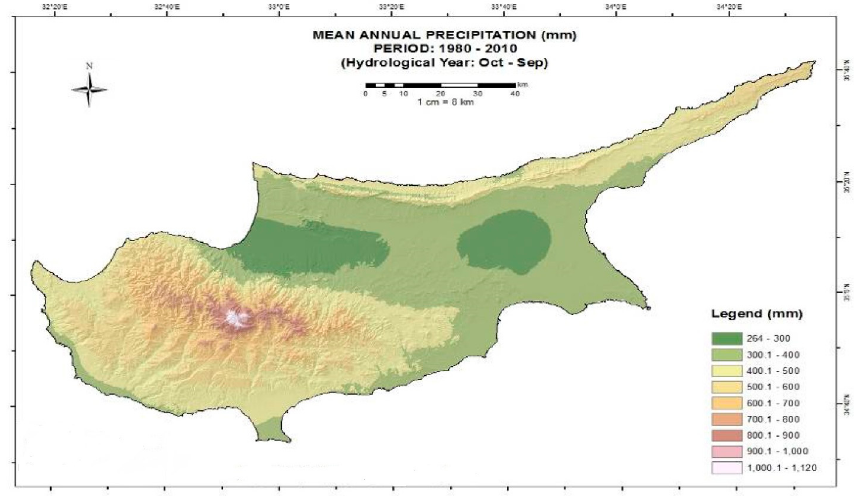
Figure 1. Mean annual precipitation (mm) (source: AGWATER project).